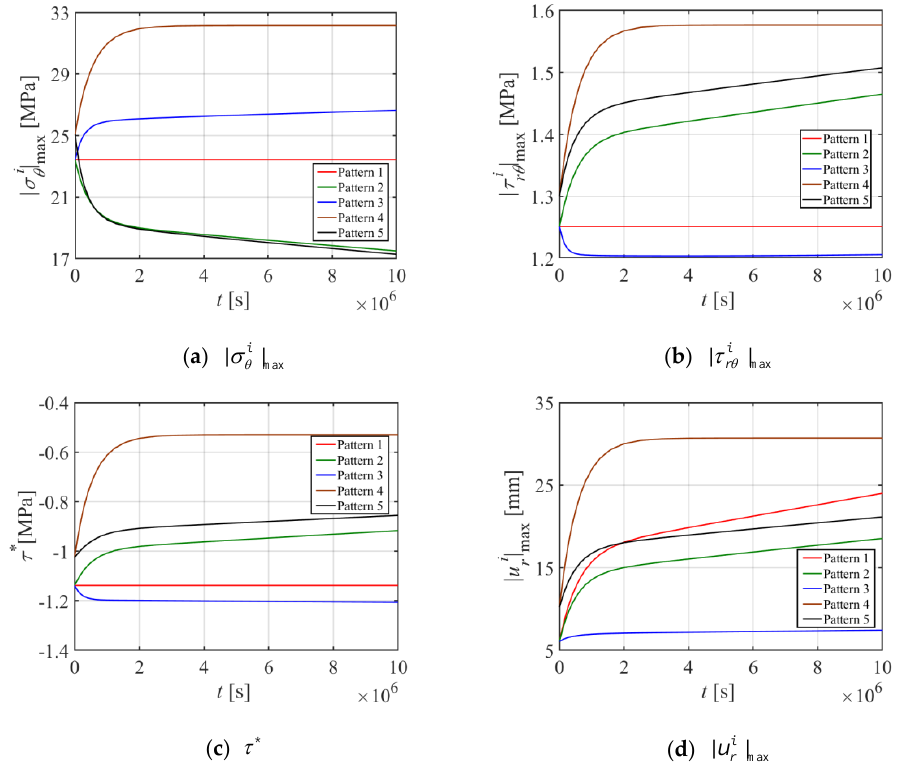
Figure 7. The variations in the stresses and displacements with time in the five modulus degrada- Figure tion patterns.